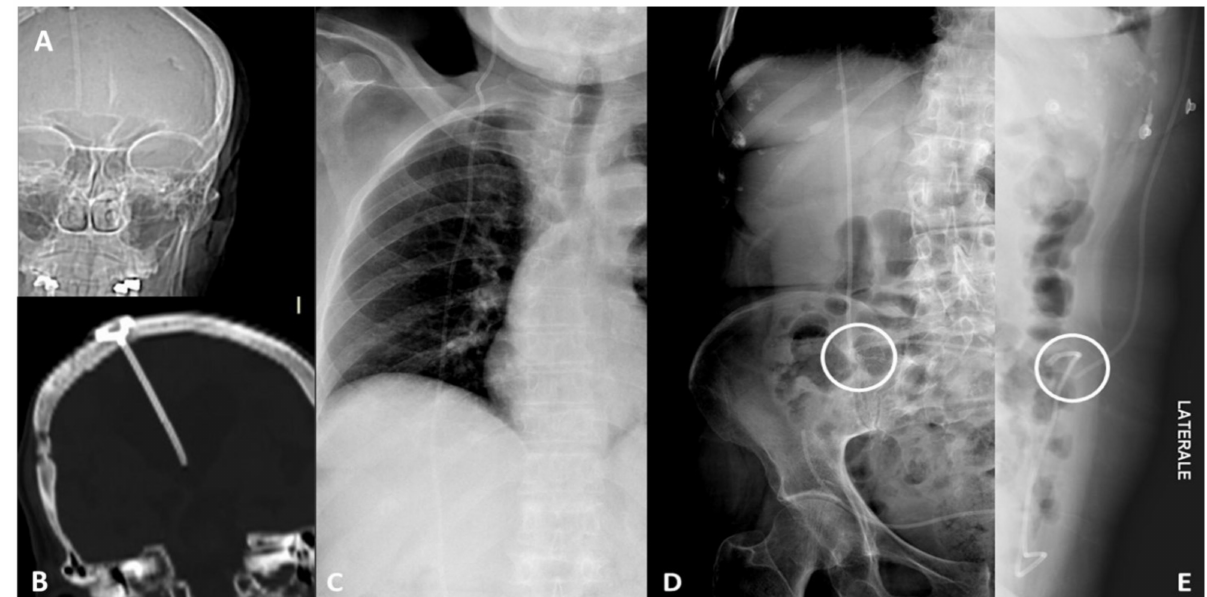
Figure 2. Device integrity. Ventriculoperioteneal shunt malfunction in a patient with history of hydrocephalus. CT scout view ( A ) and coronal CT scan ( B ) of the head show the correct placement of the tip of the shunt inside the right lateral ventricle. Frontal chest radiograph ( C ) shows the integrity of the device along its thoracic course. Frontal ( D ) and lateral ( E ) abdominal radiographs detect a fracture of the device in the right lower quadrant of the abdomen.